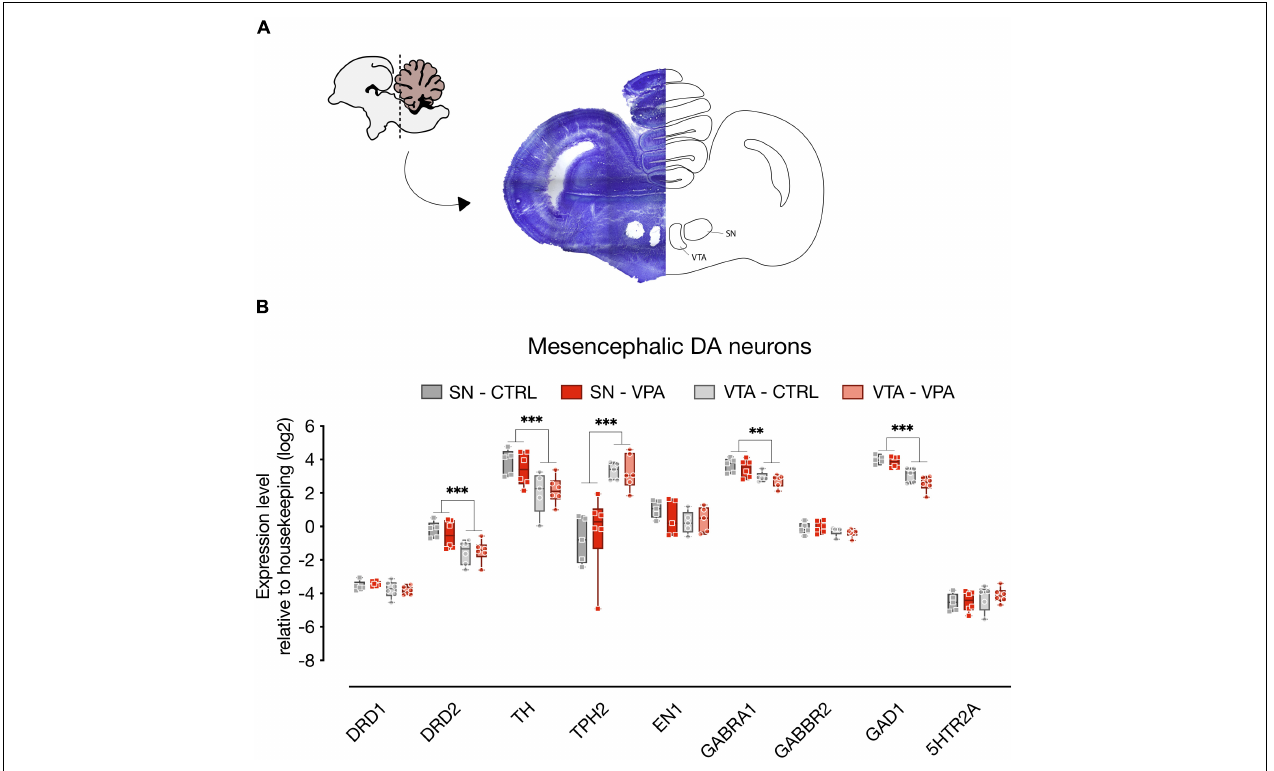
FIGURE 2 | Gene expression levels in the SN and VTA. (A) Schematic representation of the microdissected areas of interest (SN, Substantia Nigra; VTA, Ventral Tegmental Area) from coronal sections (adapted from Plate 33 in Puelles et al., 2007). (B) Box and whisker plot (median, min to max) of relative expression (dCt, log2) values for each group. Changes in expression of DRD1, DRD2, TH, TPH2, EN1, GABRA1, GABBR2, GAD1, and 5HTR2A in both SN and VTA of VPA- and vehicle-injected chicks were analyzed at P2. ∗∗ p < 0.01, ∗∗∗ p <